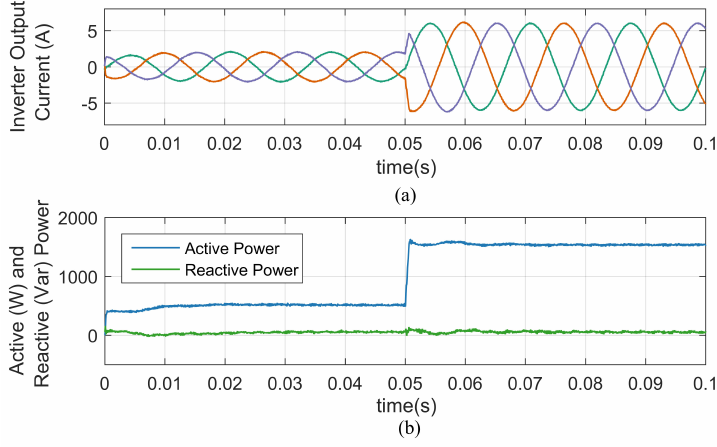
Figure 9. Simulation results with PR controller. ( a ) Three-phase output current of inverter. ( b ) Active and reactive power output.